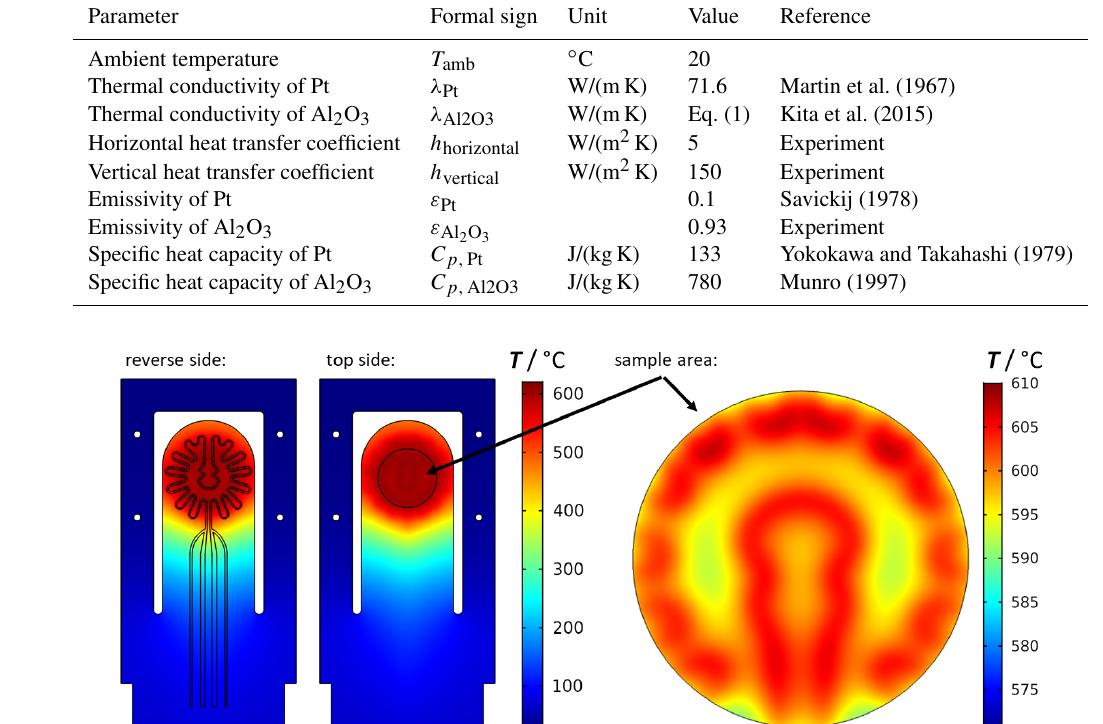
Figure 2. Simulation of the temperature distribution of the new sample holder. A screen-printed platinum structure is used to generate the temperature via Joule’s heating. On the top side, the sample area is drawn, and a detailed representation of the temperature distribution is